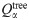
Description of the structure of the hidden Markov model (HMM).(A) In the limit of no temporal correlations, the probability over all binary spike words is given by a mixture over different emission distributions. (i) In the case of no correlation within an emission distribution, Qind has a simple product form; (ii) our full model includes pairwise correlations within an emission distribution, Qtree, having a tree graphical structure. (B) Left: The full model also includes temporal correlation through a transition probability matrix, P(α(t)|α(t−1)), which describes the probability of finding mode α at time step t given the mode present in the previous time step, t-1. The hidden state (mode identity), α, evolves probabilistically over time according to the transition matrix, and the observed pattern of spiking at time t, {σi(t)}, has a mode-dependent emission probability, Qαtree. Right: Schematic representation of the tree graphical structure of each emission distribution. (C) In order to find the stationary distribution of the HMM, we solved for the set of mode weights, {wα}, using the detailed balance equation. (D) The total number of modes, M, was determined by finding the maximum 2-fold cross-validated likelihood of the model. Note that the optimum was relatively shallow, so that the model is not sensitive to the precise number of modes, as long as it lies within a certain range (for this dataset, roughly 30–100 modes).